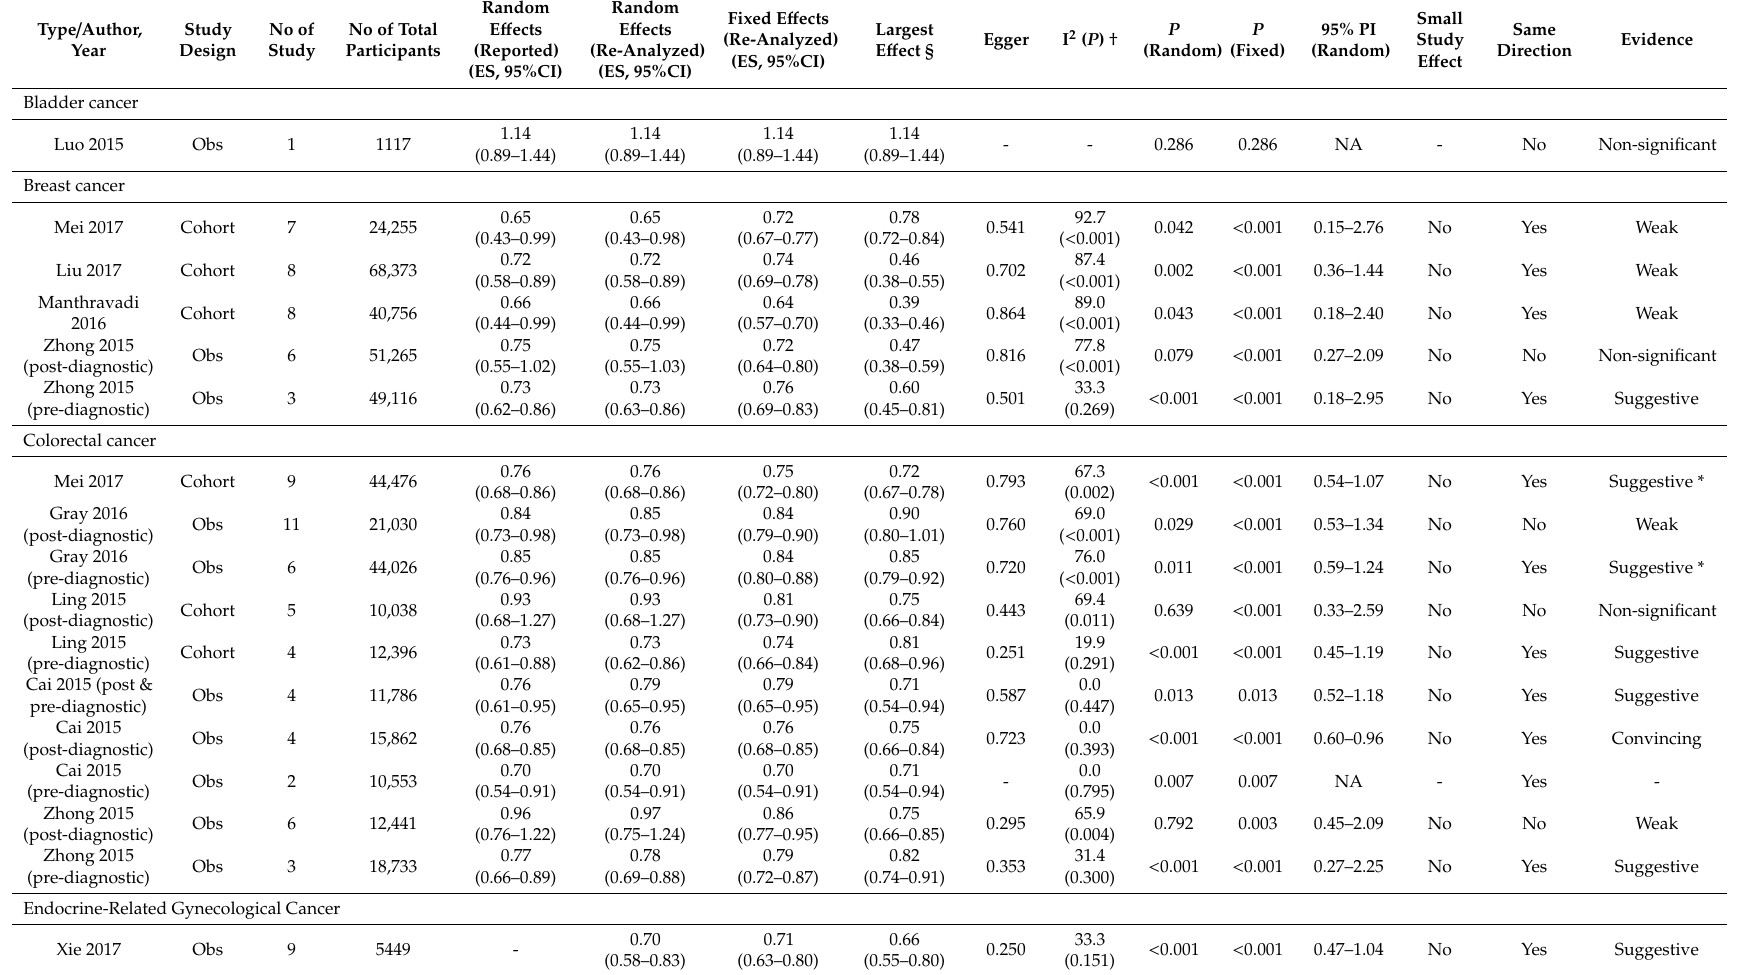
Table 1. Summary of each individual meta-analysis on associations of the use of statin and all-cause mortality in various